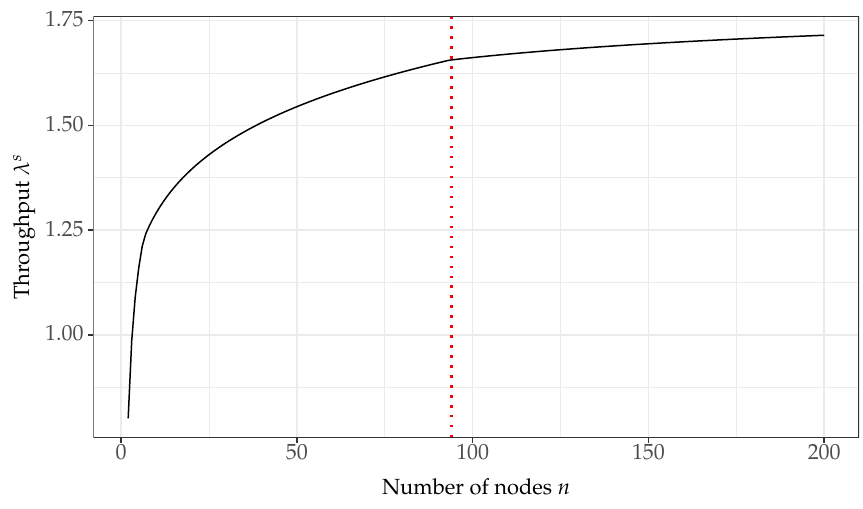
Figure 6. Number of nodes versus throughput.